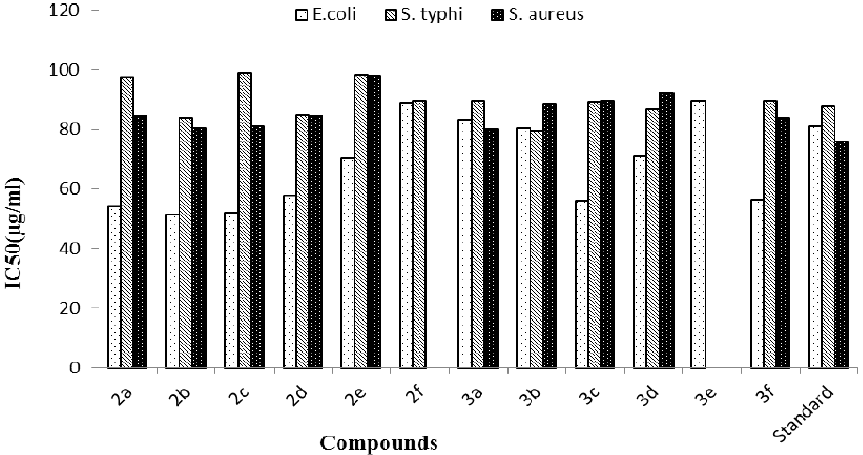
Figure 8. IC 50 values of antibacterial activity.